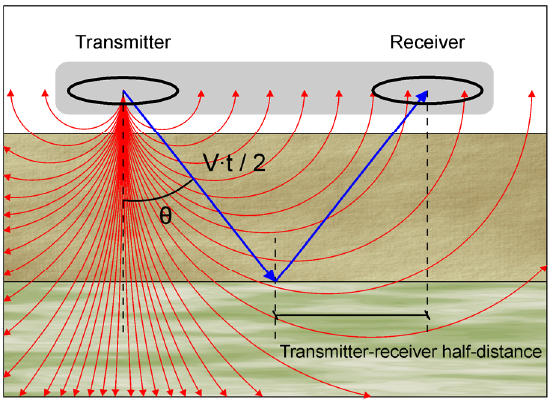
Figure 3. Illustrative sketch of the dipolar effect, which is zero in the plane of the antennas and maximum in the perpendicular direction.